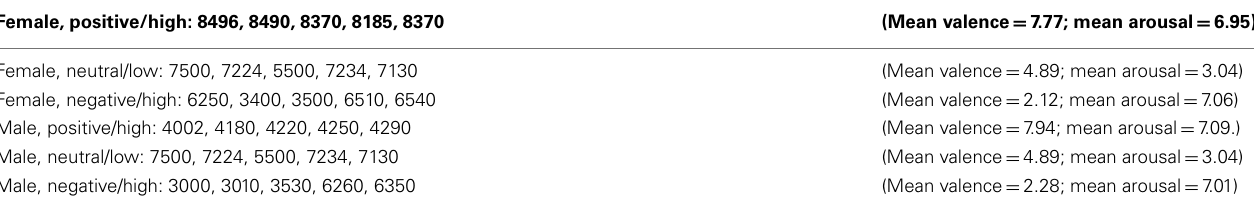
TableA1 |An overview of the selected pictures of different subsets for gender, valence and arousal (the mean valence rating and the mean arousal rating of the IAPS pictures are presented in